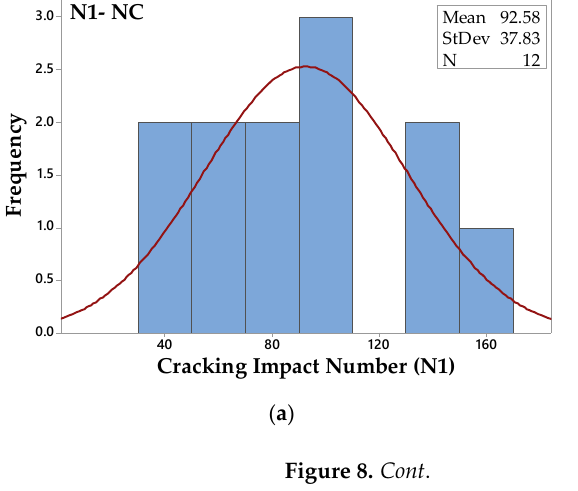
N1- HC Figure 8. Cont